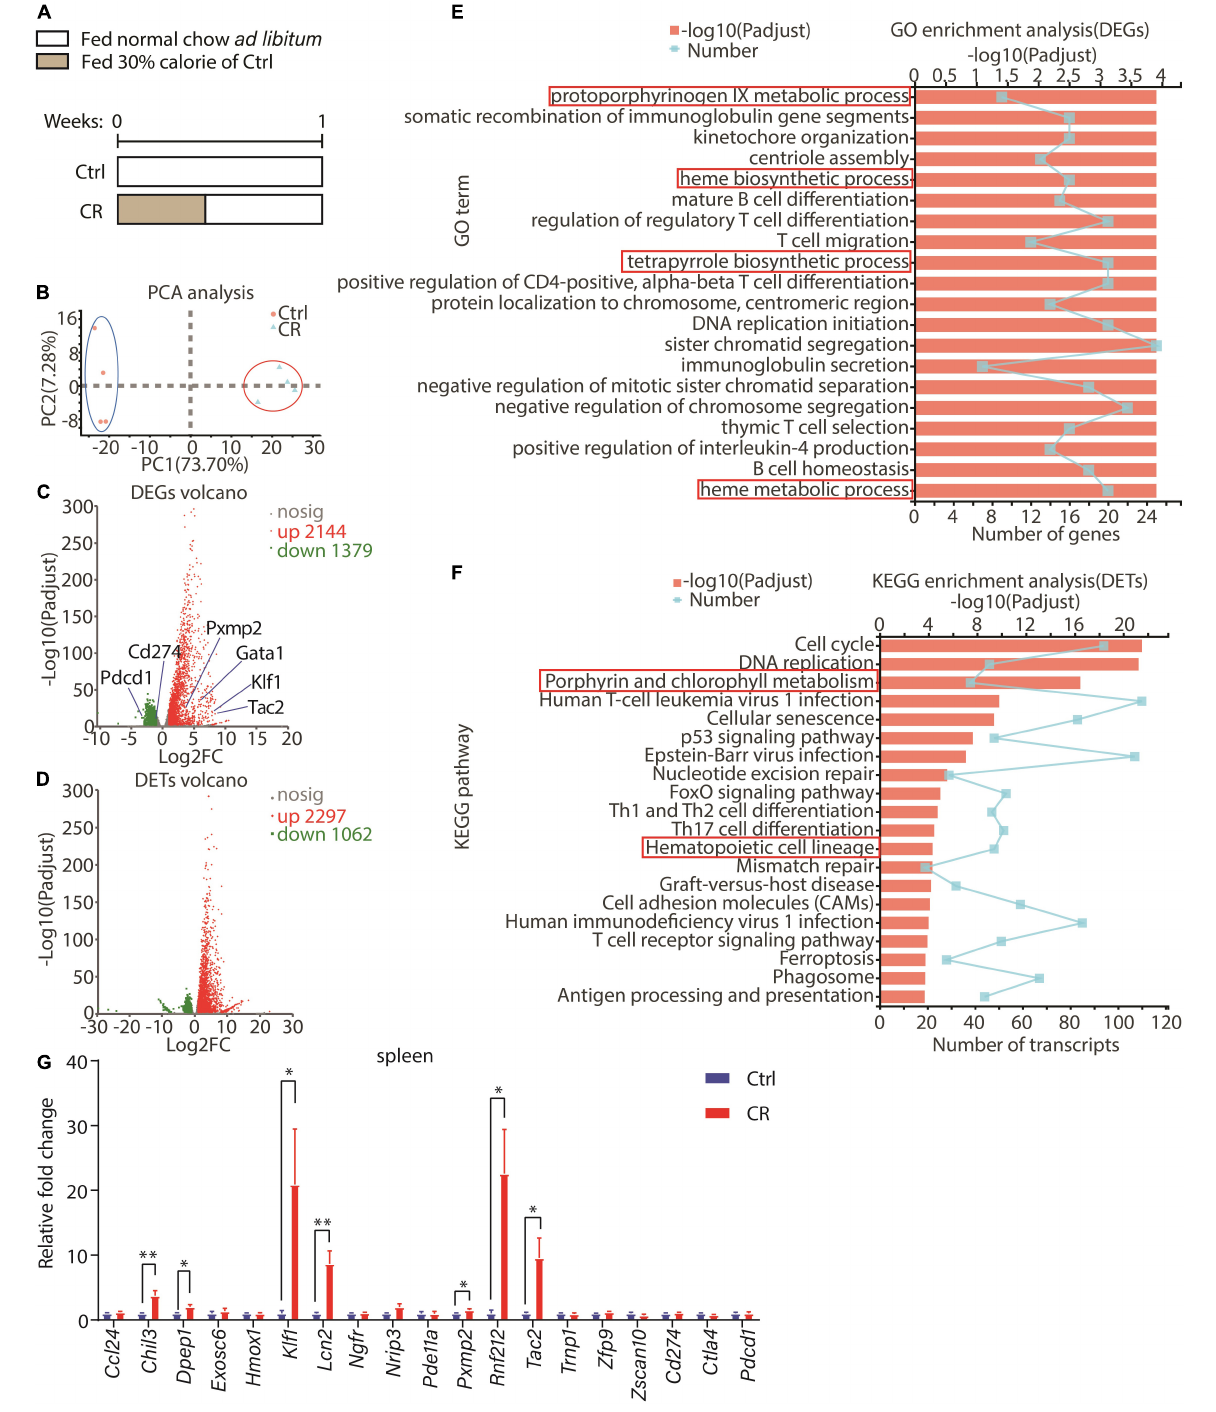
Frontiers in Nutrition |